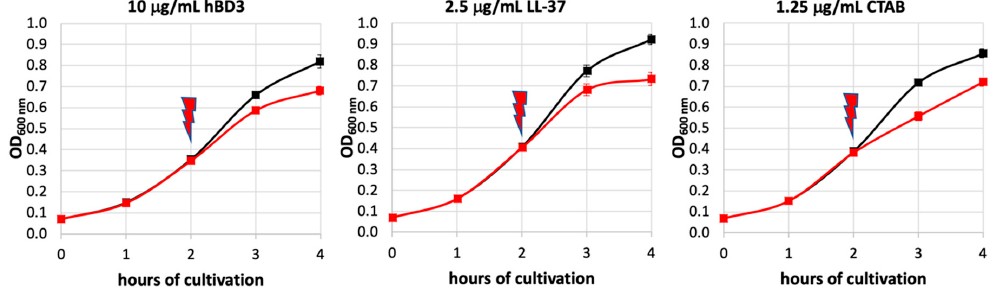
Figure 2. Effect of hBD3, LL-37, or CTAB on the growth of Streptococcus pneumoniae D39, respectively. The red arrow indicates the application of either compound after two hours of cultivation. Growth curves obtained under control condition are colored in black. Growth curves obtained under stress condition are colored in red. Error bars represent the standard deviation. n = 4 (hBD3), n = 6 (LL-37) [6], n = 4